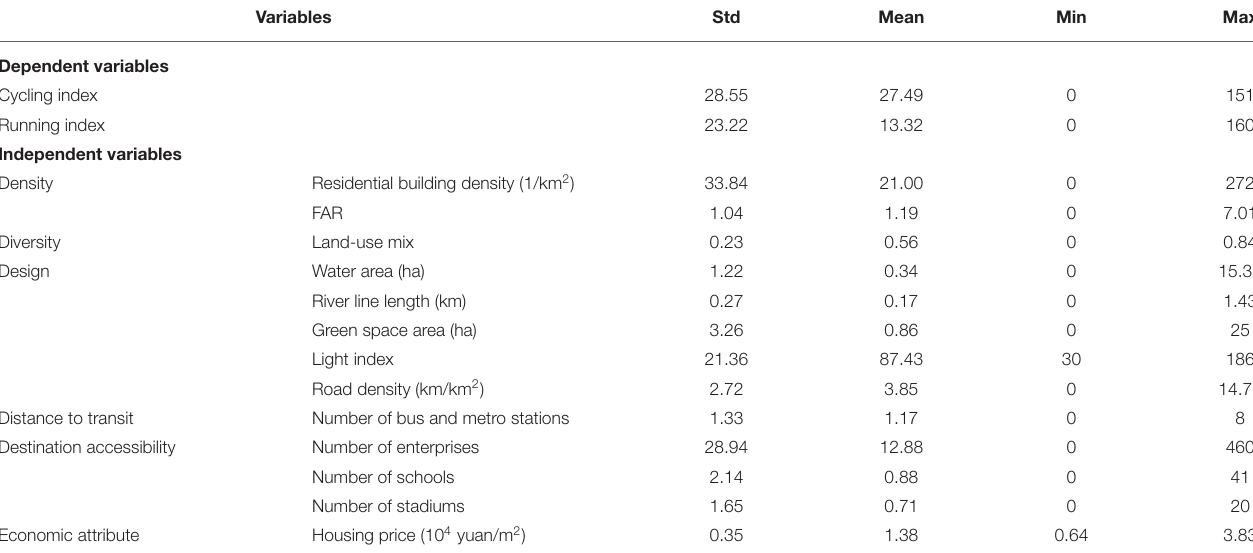
TABLE 1 | Descriptive statistics of the